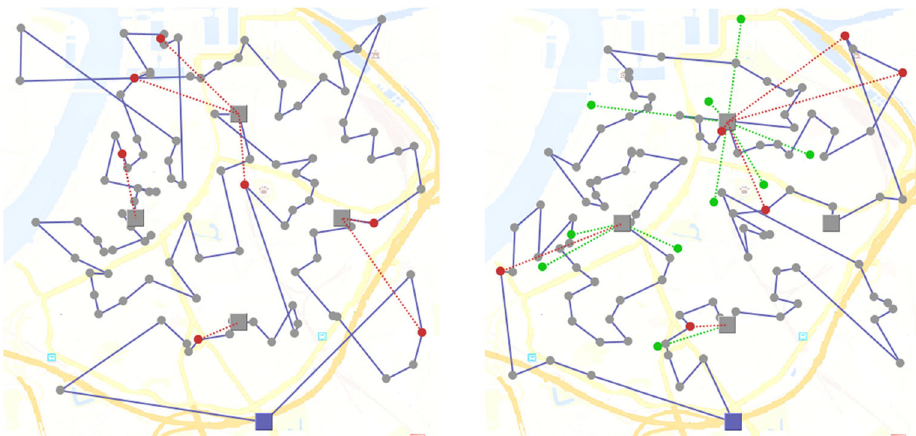
Fig. 2 Simulated delivery route. Starting from the highway exit,all customers (dots) and DPs (squares) are visited once. Red dots denote failed deliveries. (right) Green dots indicate self- pick-up customers